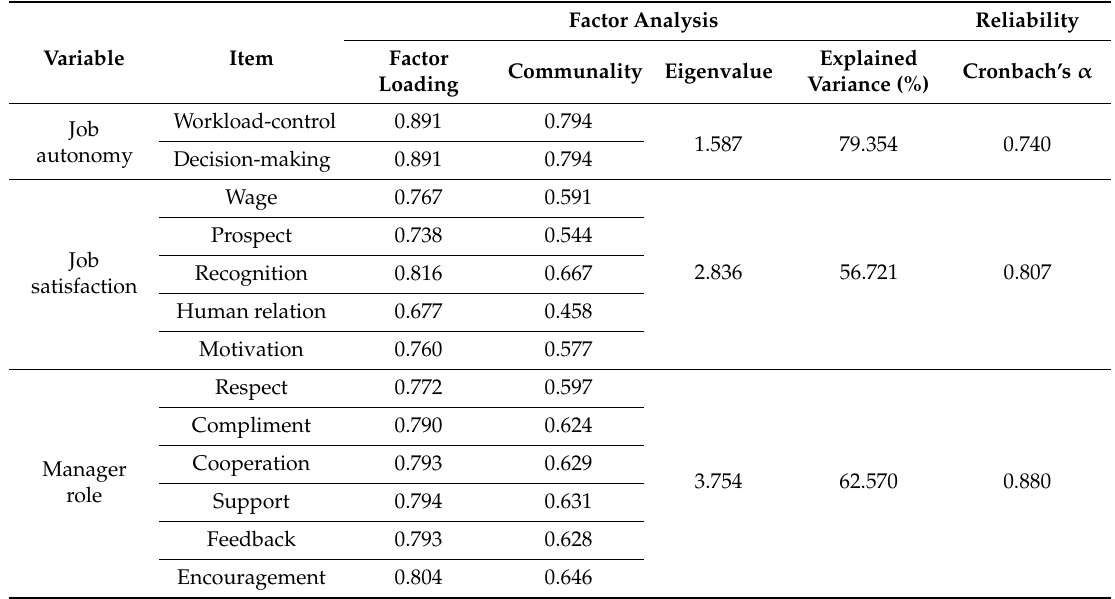
Table 1. Reliability and validity of